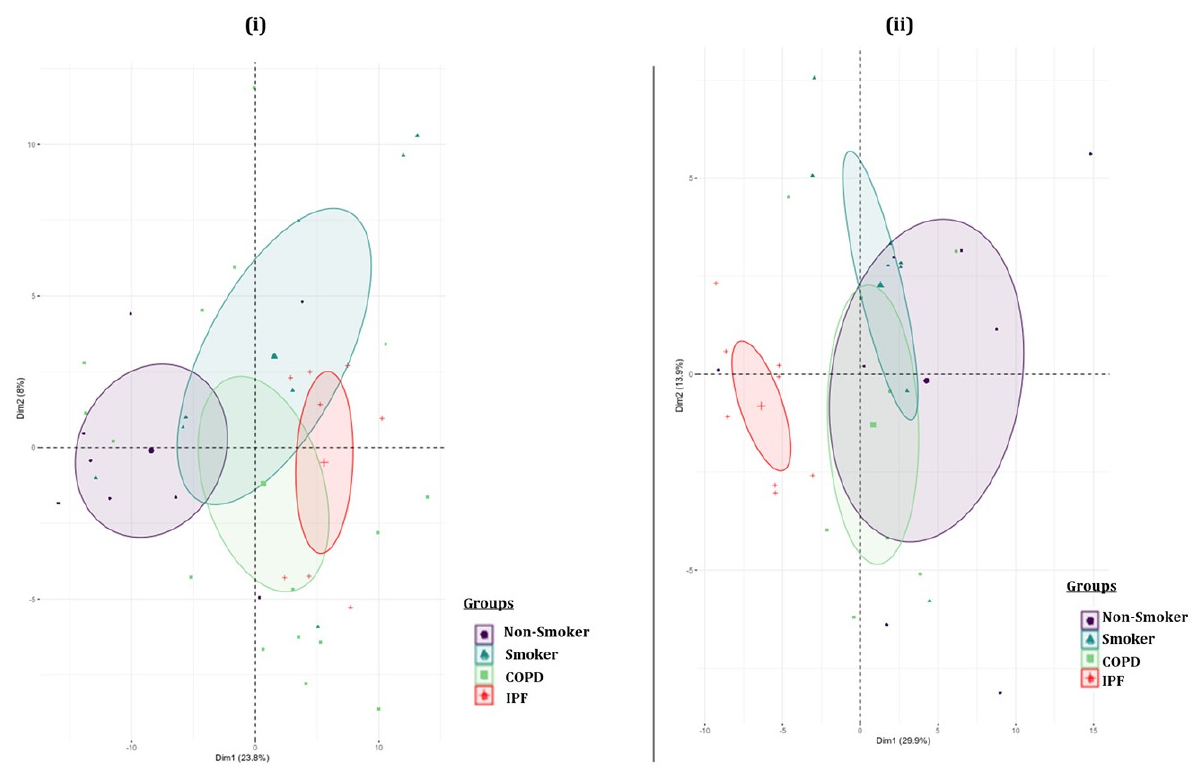
Figure 3. Principal component plot. Principal component analyses based on differential microRNA expression in individual ( i ) BALF- and ( ii ) lung-tissue-derived exosome samples from non-smokers, cigarette smokers, and COPD and IPF subjects.